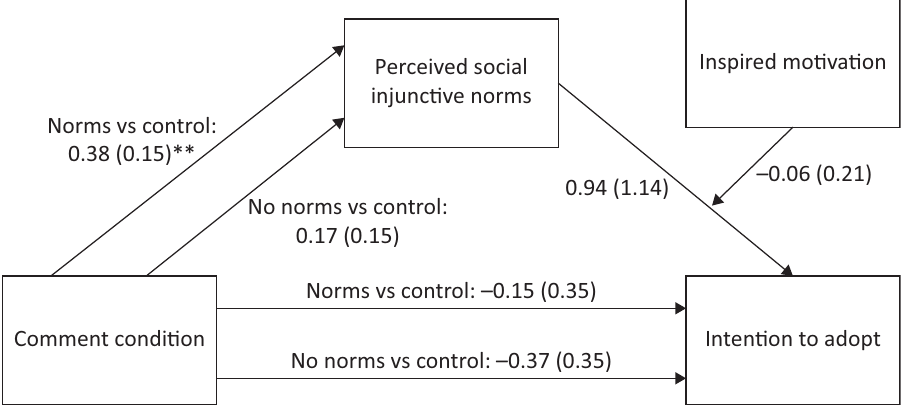
Figure 3. Moderated-mediation effect of comments on intention to adopt through perceived injunctive norms. Notes: * p ≤ 0.05, ** p ≤ 0.01. Coefficients associated with each path presented as b (SE). Model statistics: Step 1— F (2,160) = 3.38, p = 0.04, adj. R 2 = 0.03; Step 2— F (5,157) = 3.27, p = 0.05, adj. R 2 =